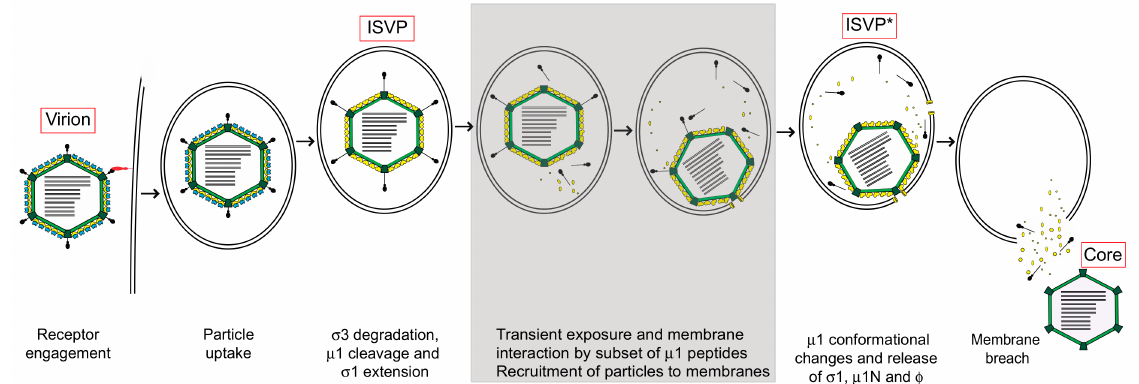
Figure 2. Reovirus entry schematic. Reovirus virions are internalized following engagement to cell surface receptors and disassemble to form infectious subvirion particles (ISVPs) within the endosomal compartment. ISVPs undergo conformational transitions to form ISVP*s and release µ 1 fragments that facilitate membrane penetration. We propose (shown in grey boxes) that a small proportion of µ 1 fragments are exposed or released from the particles following ISVP formation. These fragments interact with the host membrane and recruit ISVP-like particles to host membranes and promote their conversion to ISVP*s. Red boxes indicate key virus entry